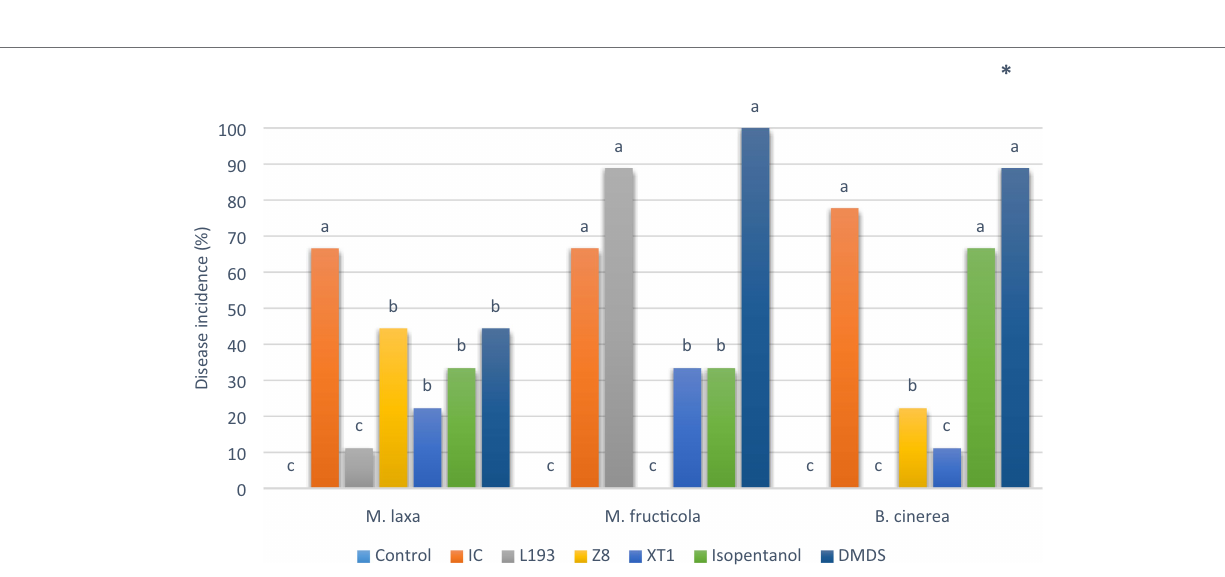
FIGURE 3 | In vivo antagonistic activity of volatile organic compounds (VOCs) from B. atrophaeus L193, B. velezensis XT1 and P. vulpis Z8, as well as the synthetic compounds isopentanol and dimethyl disulphide. The figure shows the disease incidence of cherry fruits artificially inoculated with M. laxa , M. fructicola and B. cinerea . Control: control treatment without bacterial VOCs or volatile synthetic compounds. IC: pathogen infection control without VOC treatment. Differences between treatments were tested for statistical significance using Chi-squared test: * ( p ≤ 0.05), ** ( p ≤ 0.01), *** ( p ≤ 0.001) and ns (not